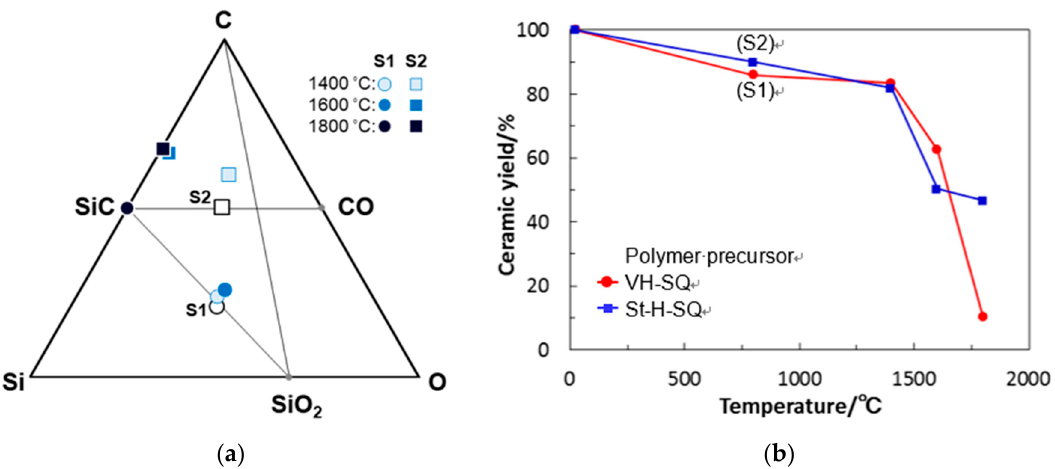
Figure 12. Thermal behaviors of VH-SQ-derived S1 and St-H-SQ-derived S2 during heat treatment up to 1800 °C in Ar. ( a ) Chemical composition changes and ( b ) ceramic yields.